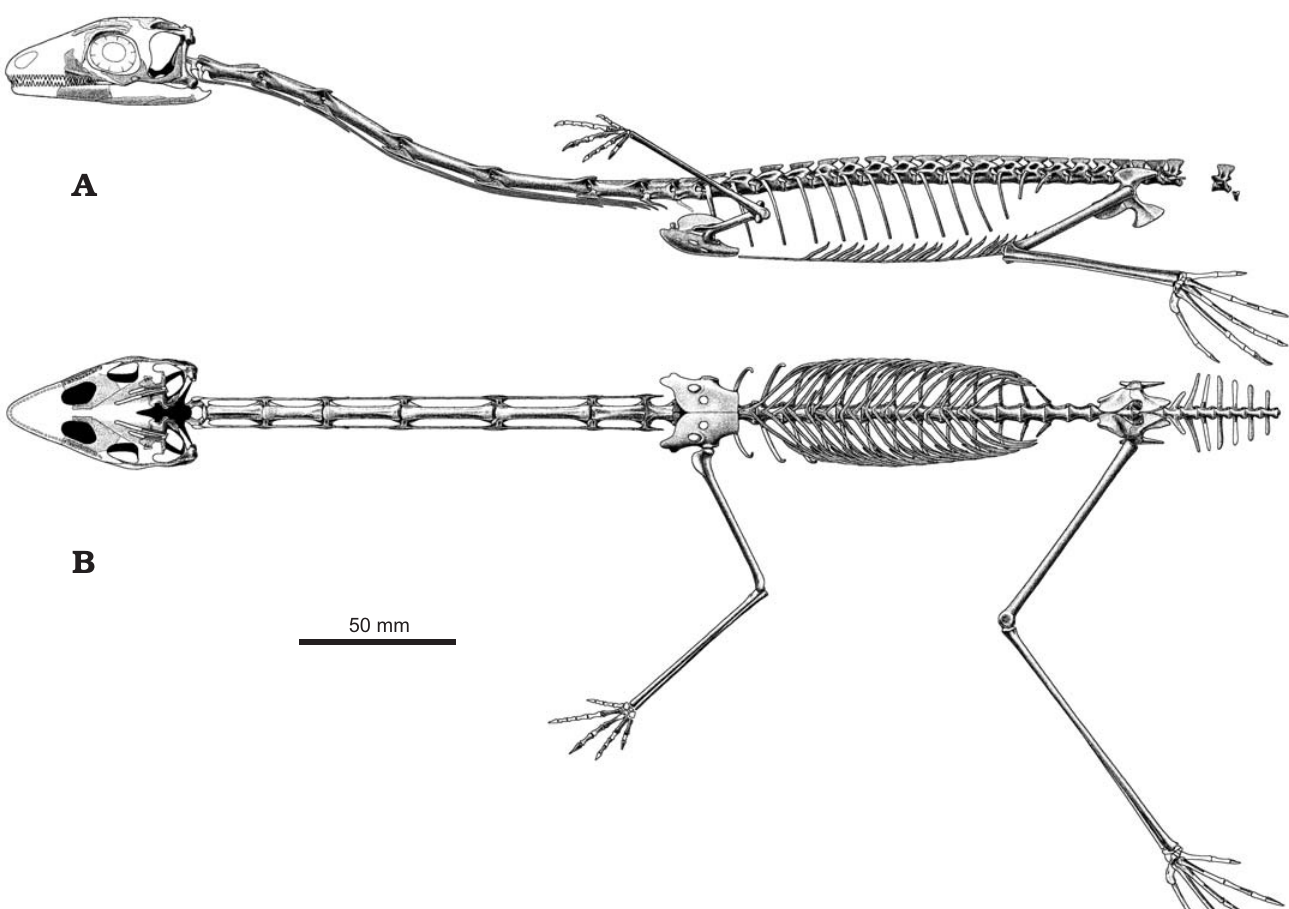
Fig. 13. Restoration of the skeleton of long-necked reptile Ozimek volans gen. et sp. nov. in a gliding pose; left lateral ( A ) and ventral ( B )